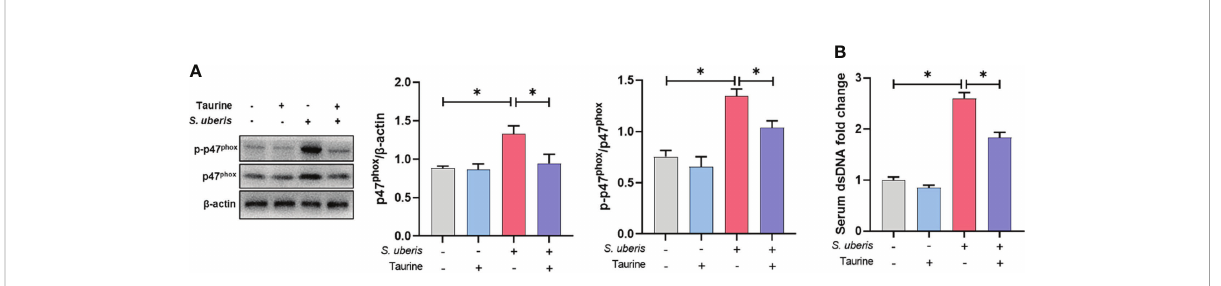
FIGURE 7 Taurine inhibits NAPDH oxidase activity and NETs production in S. uberis- induced mastitis in mice. (A) Immunoblot and statistical analysis of p47 phox proteins and phosphorylated proteins. (B) The dsDNA change in serum. Data are presented as mean ± SEM (n = 6). * P <